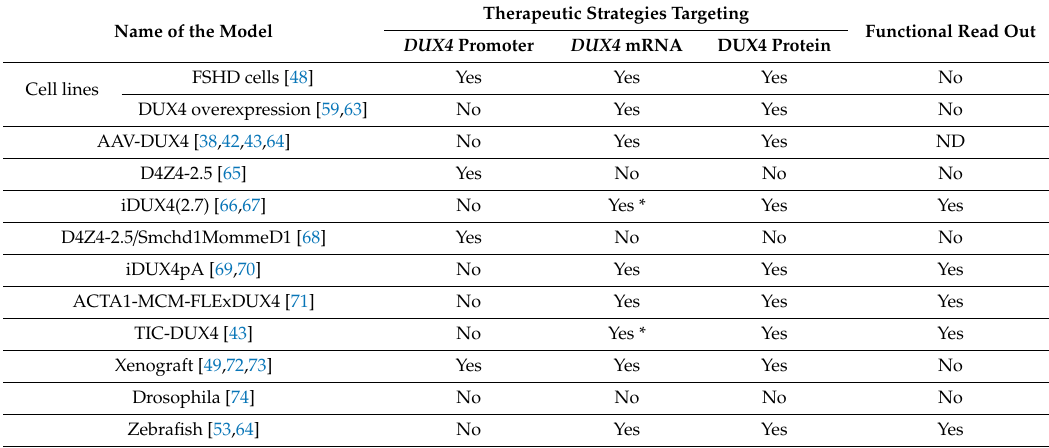
Table 1. Models that can be used depending on their therapeutic